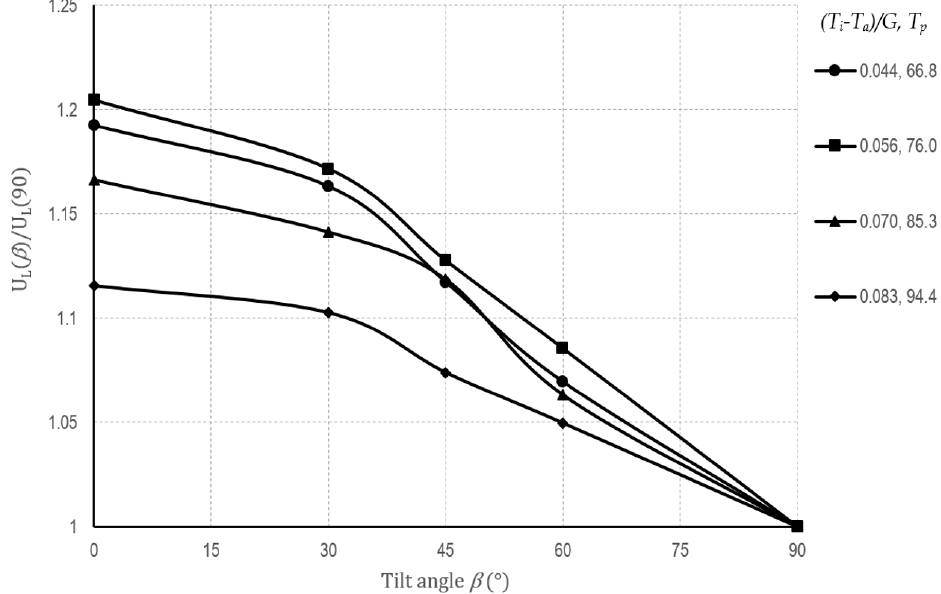
Figure 4. U L ( β )/U L (90°) vs. β and ( T i − T a )/ G , for Case 1, at Q u ( β ) > 0.